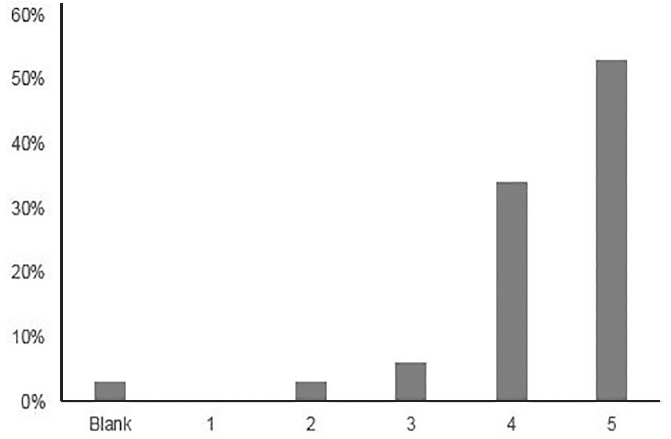
Figure 1. Participant responses on a Likert scale ranging from 1 (poor) to 5 (excellent) in response to the question “Please rate this overall program”